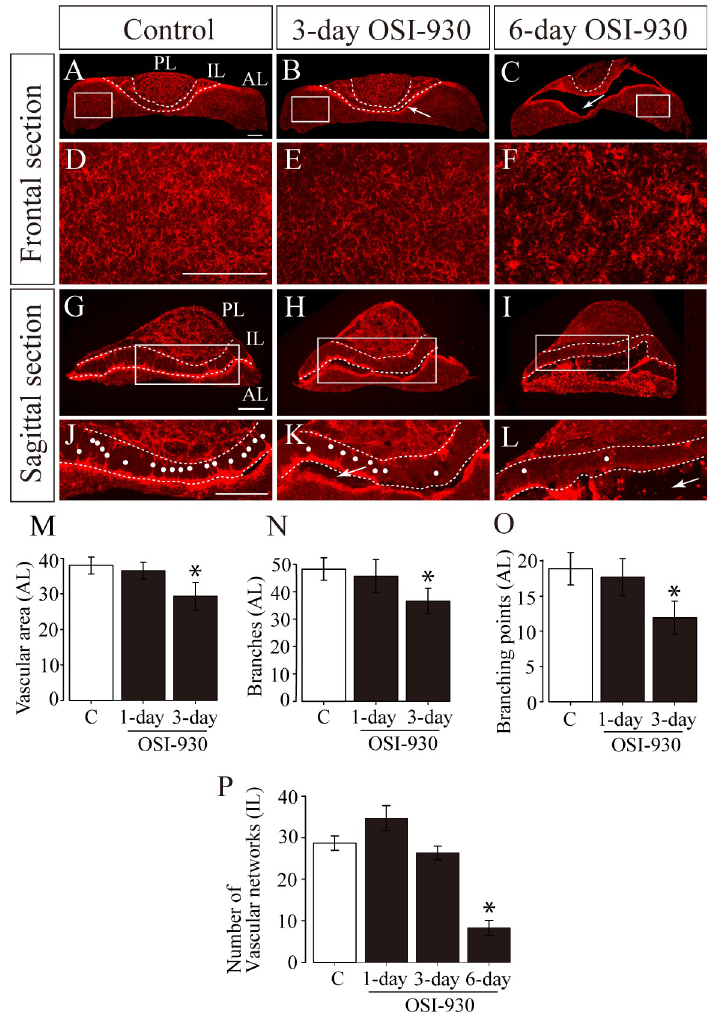
Fig 2. VEGFR inhibition disrupts pituitary vasculature. (A-F) Representative frontal sectional images of pituitaries labelled by isolectin B4 staining in control (A and D), three-day OSI-930-treated (B and E), and six-day OSI- 930-treated (C and F) groups. Boxed regions in A-C are enlarged in D-F, respectively. (G–L) Representative sagittal images of pituitaries labelled by isolectin B4 staining in control (G and J), three-day OSI-930-treated (H and K), and six-day OSI-930-treated (I and L) groups. Boxed regions in G-I are enlarged in J-L, respectively. White dots indicate capillary plexus with a palisade-fashion arrangement in the intermediate lobe. In OSI-930-treated groups, hematoma cavities were observed around Rathke’s cleft (arrows; B, C, K, and L), and capillary networks in the intermediate lobe were decreased compared to control (dots: J-L). In addition, capillaries around Rathke’s cleft were diminished compared to control. (M-P) Quantitation of vascular area, branches and branching points in the anterior lobe, and vascular networks in the intermediate lobe. The vascular are (M), branches (N) and branching points (O) were decreased in the anterior lobe, and the number of capillary plexus with a palisade-fashion arrangement was decreased in the intermediate lobe (P) in a treatment-day dependent manner ( � P < 0.05, t-test). Bars, 200 μ m. AL, anterior lobe; IL, intermediate lobe; PL, posterior lobe; C,